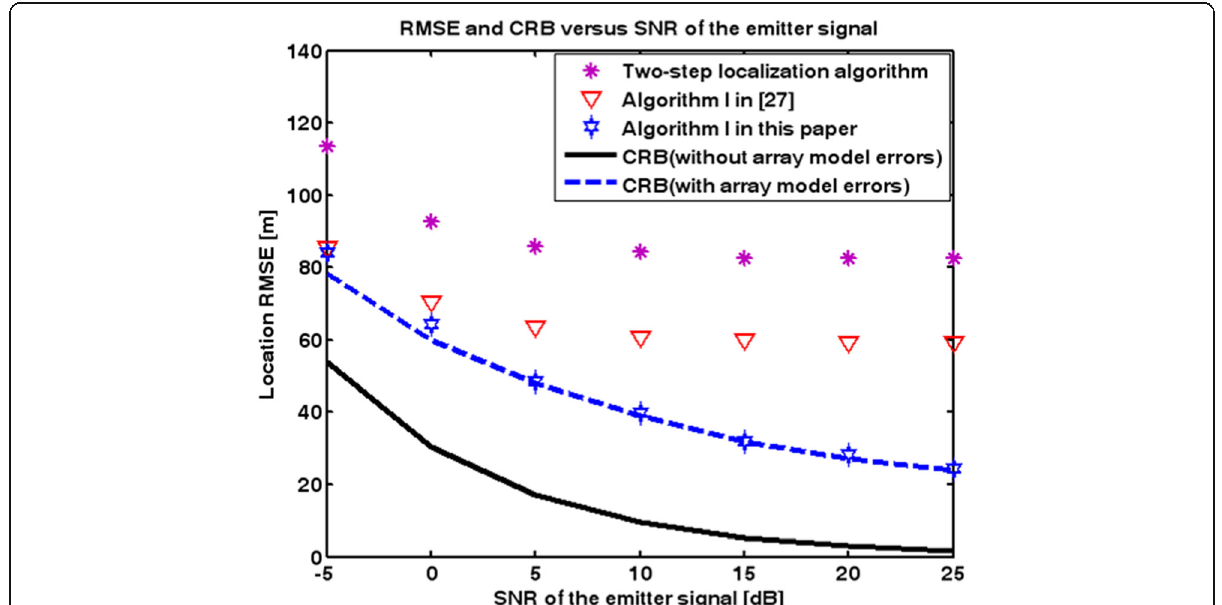
Fig. 1 RMSEs of localization methods and the corresponding CRBs as a function of SNR of the emitter signal for case of unknown signal